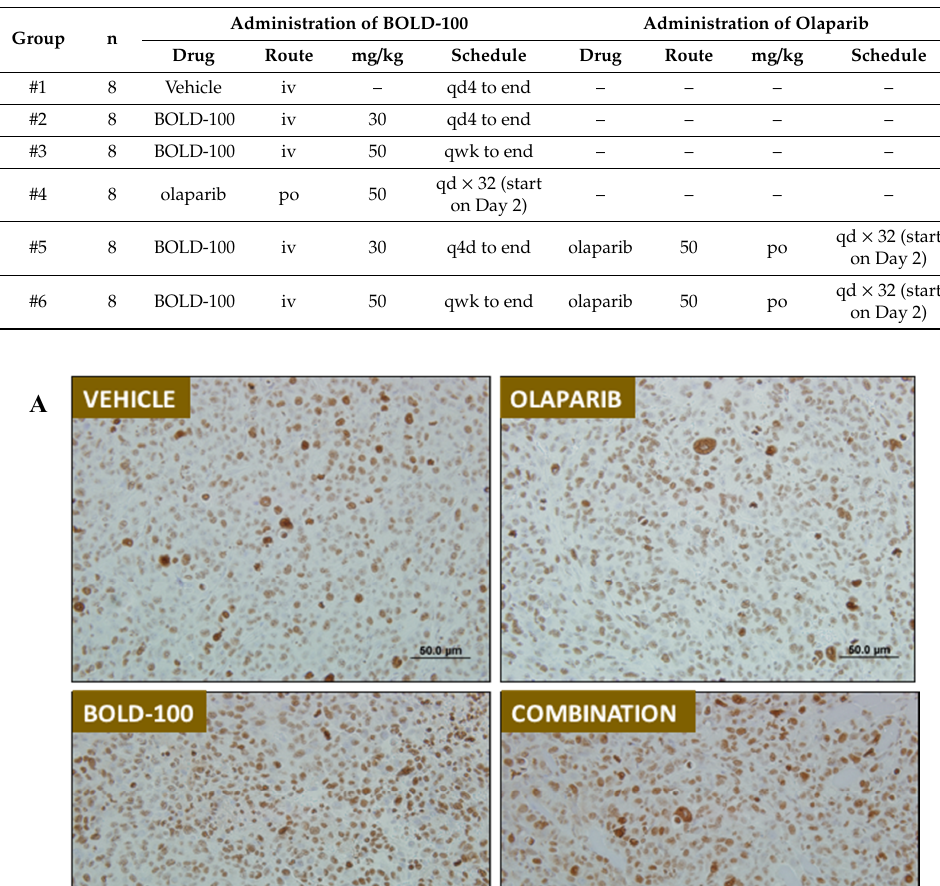
Table 2. MDA-MB-231 in vivo xenograft study design as of Day 1.